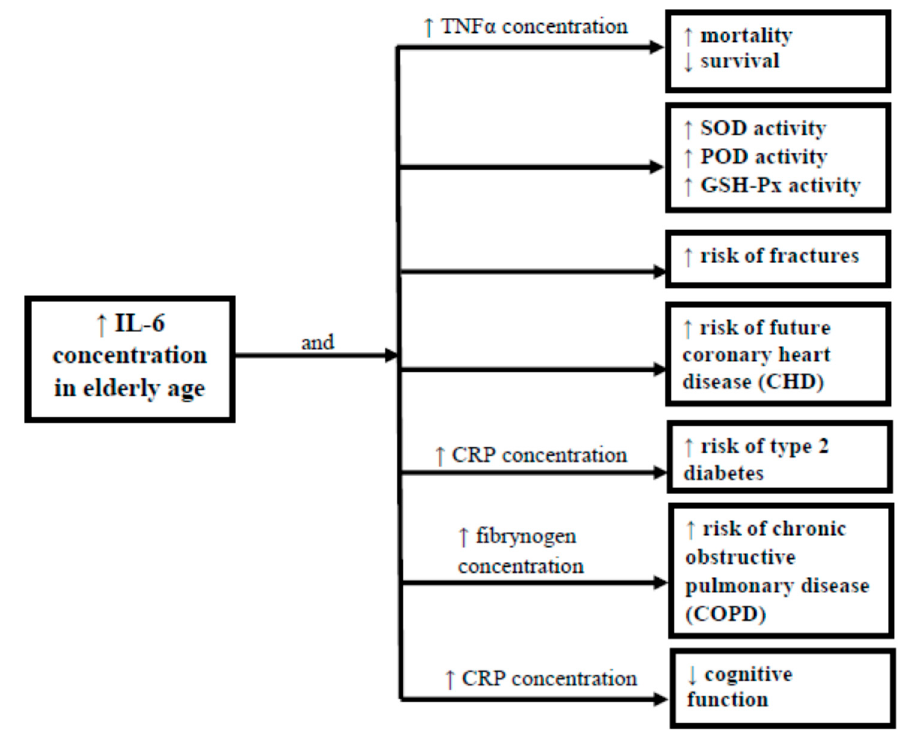
Figure 1. Relations between biochemical parameters and the supposed consequences in health and longevity.